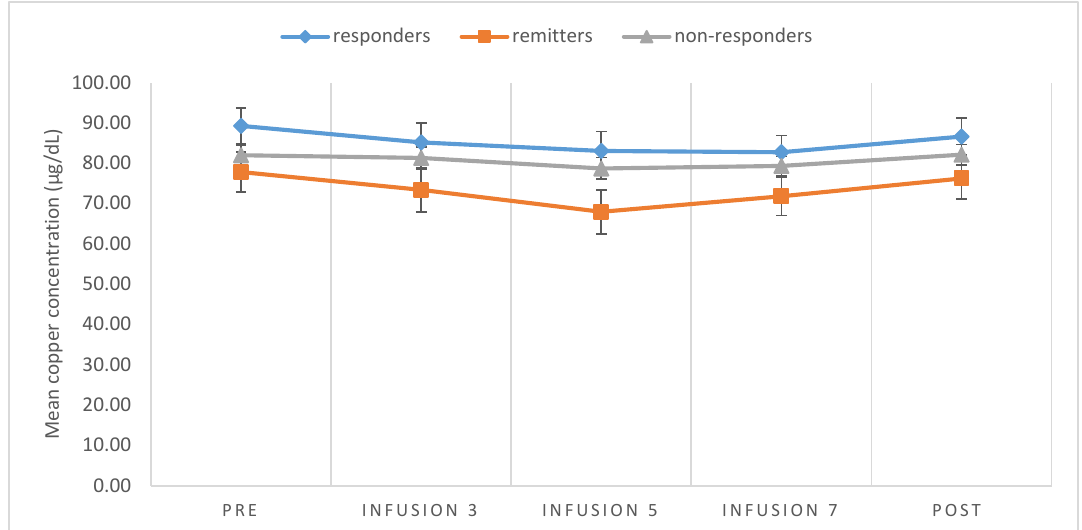
Figure 2. Mean values and standard errors for changes in copper serum levels among responders, remitters, and non-responders.